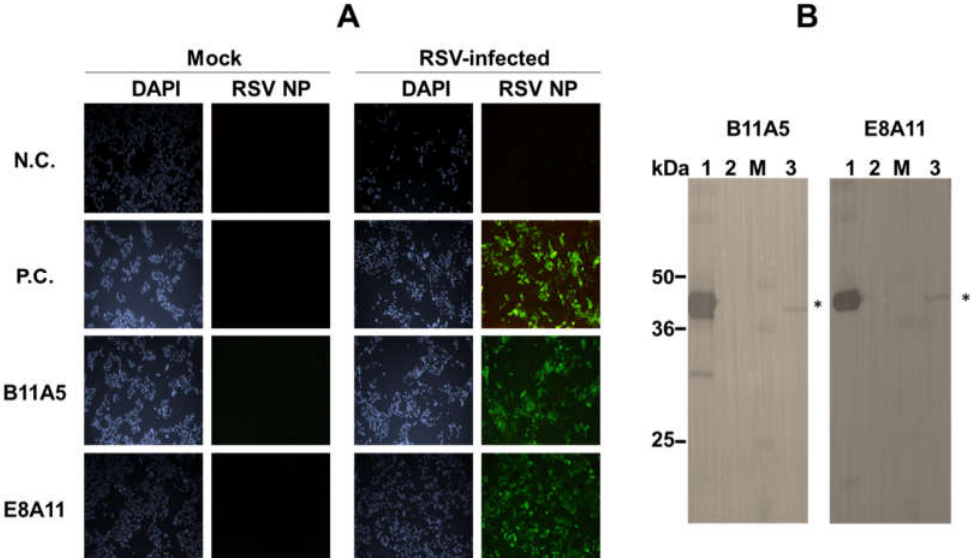
Figure 2. Characterization of monoclonal antibodies against respiratory syncytial virus (RSV). ( A ) Cells were independently infected with the virus for 24 h and fixed with 4% paraformaldehyde. After fixation, cells were treated with lysis buffer and washed with phosphate buffered saline with 0.1% Tween-20 (PBST) three times. Green fluorescence was detected with a fluorescein isothiocyanate (FITC)-conjugated secondary antibody. N.C., negative sera; P.C., commercial anti-RSV NP antibody; Mock, uninfected. All images were acquired by resolution power setting with 100×. ( B ) Western blotting was conducted using an RSV-infected cell pellet. 1, purified RSV recombinant nucleoprotein (rNP; 5 μg/lane); 2, BSA (5 μg/lane); 3, marker; 4, RSV (1 × 10 6 TCID 50 /mL)-infected cell pellet (4 μg/lane). Asterisk indicates RSV NP protein.